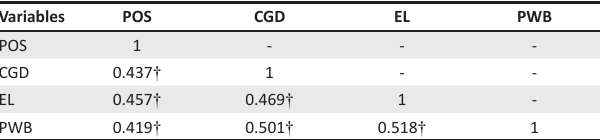
TABLE 3: Correlation